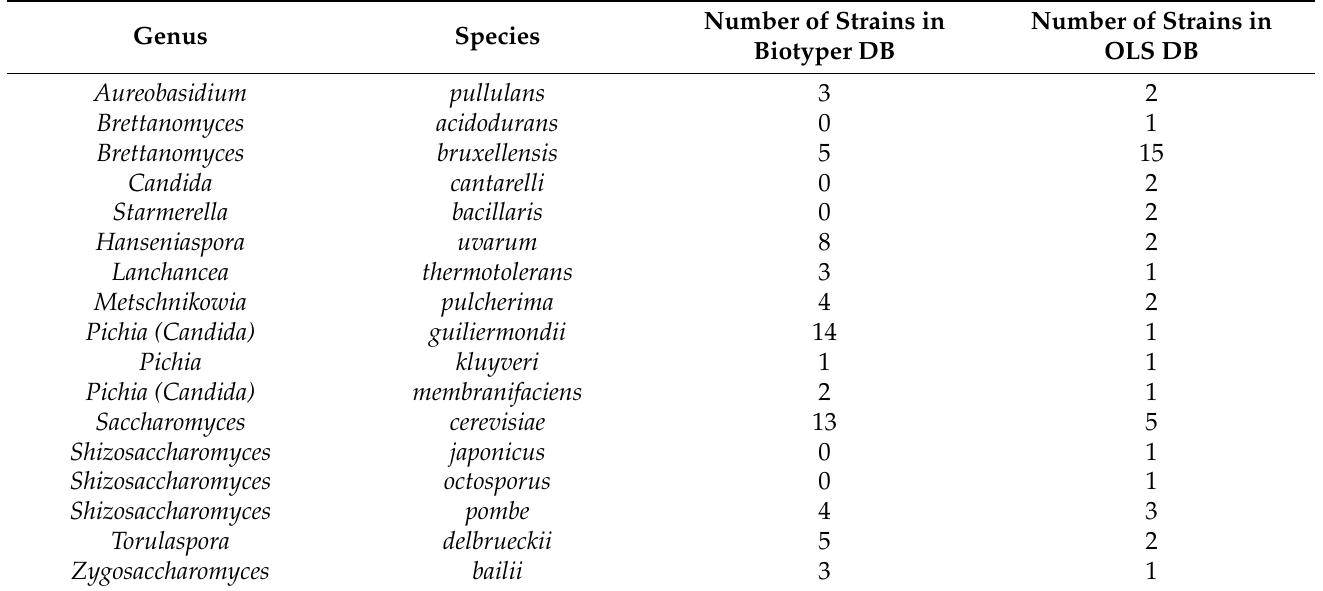
Table 1. Numbers of strains per species in the Biotyper database (Biotyper DB) and the oenological laboratory specific database (OLS